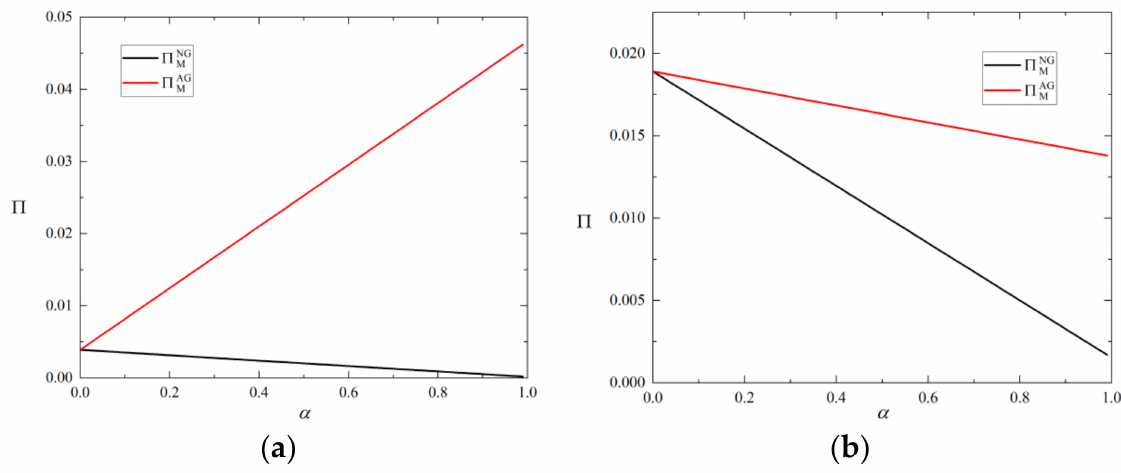
Figure 5. Profit of the manufacturer under Models NG and AG. ( a ) c n = 0.45, ( b ) c n =